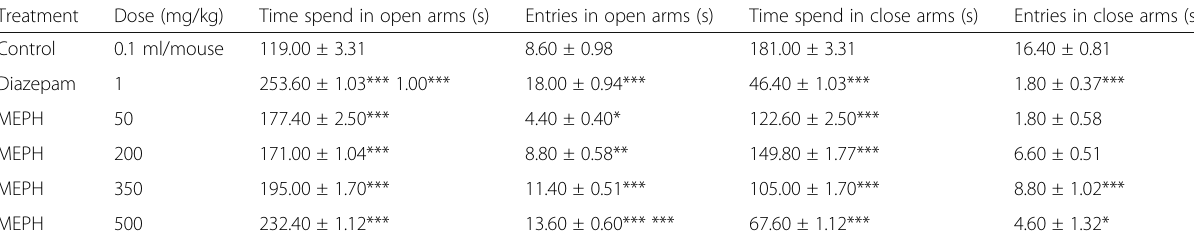
Table 6 The effect of MEPH on elevated plus-maze test in mice Treatment Dose